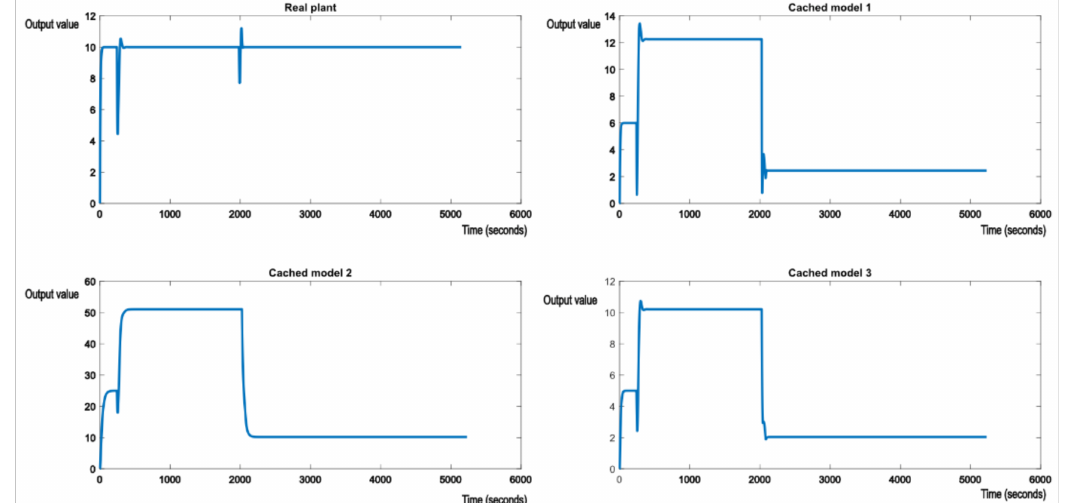
Figure 7. Evolution of the real plant and the nominal models after exposing the real plant to perturbations.